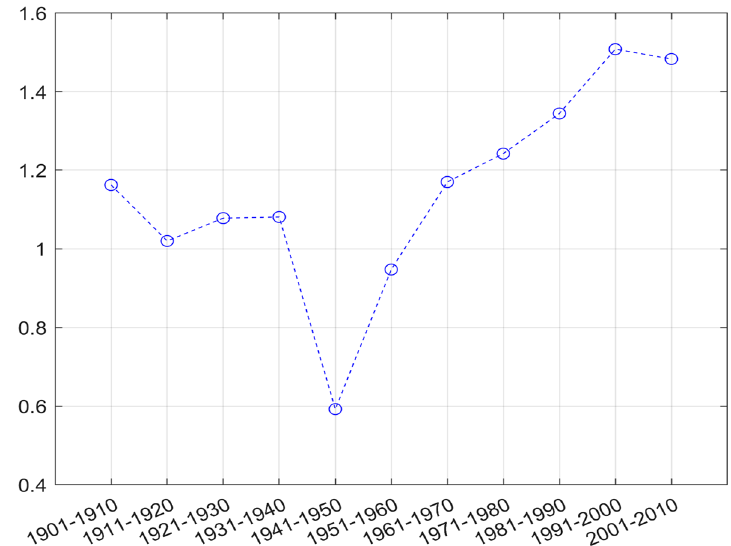
Fig. 9 Global efficiency of the football networks per decade. An ascending trend is witnessed, with the exceptions due to the world